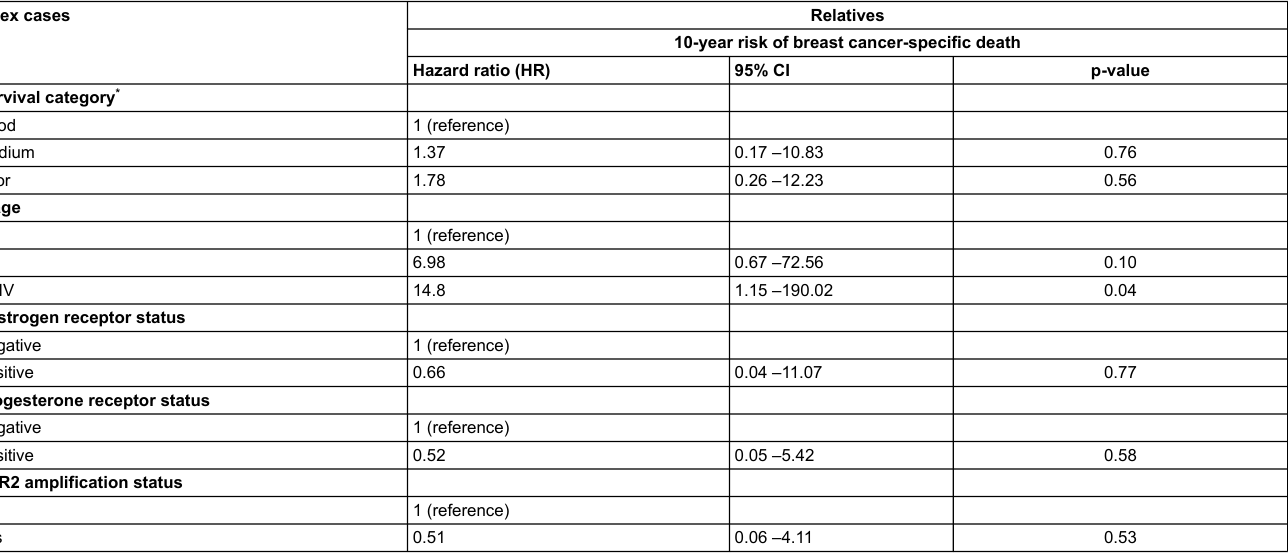
Table 5: Breast cancer-specific survival in